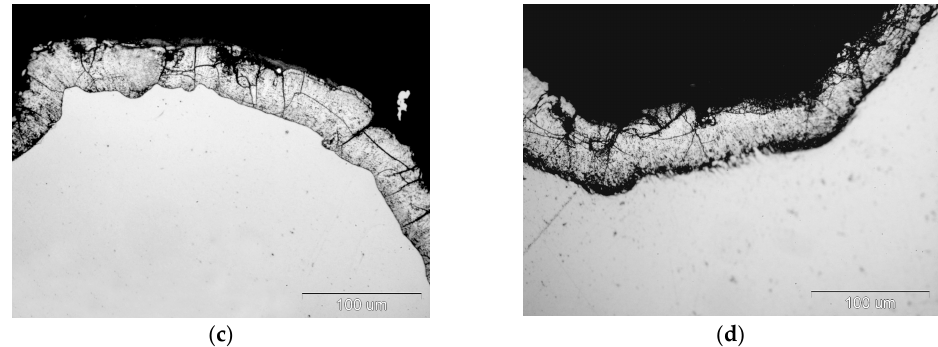
Figure 1. Appearance of surface ( a ) and cross-section of coating on bolt head ( b ), thread tip ( c ), and thread groove ( d ) of grade 10.9 bolt.